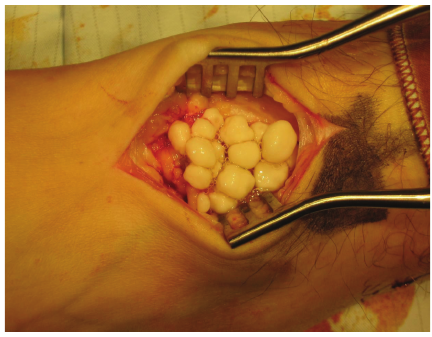
Figure 2: Arthrotomy of the ankle showing loose intra-articular bodies.